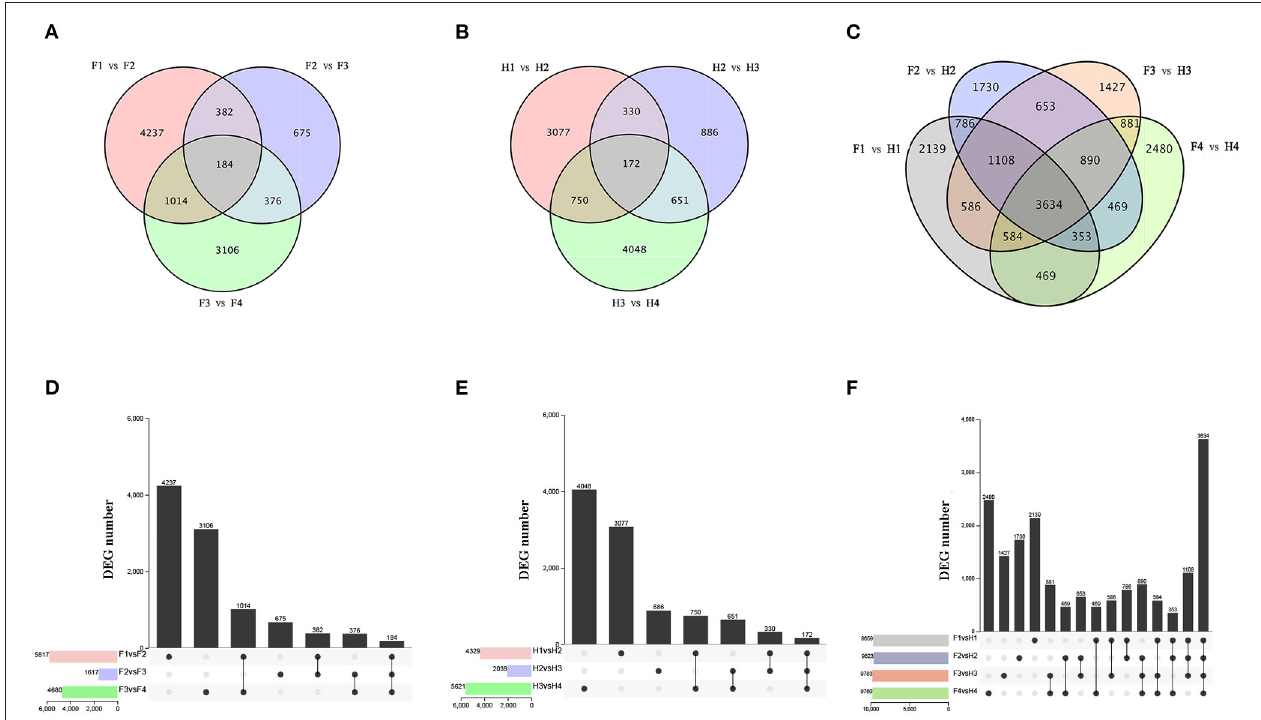
FIGURE 3 | Analysis of differentially expressed genes (DEGs) under drought stress in two cultivars. (A–C) : Venn diagrams of DEGs; (D–F) : Bar graphs of DEGs.